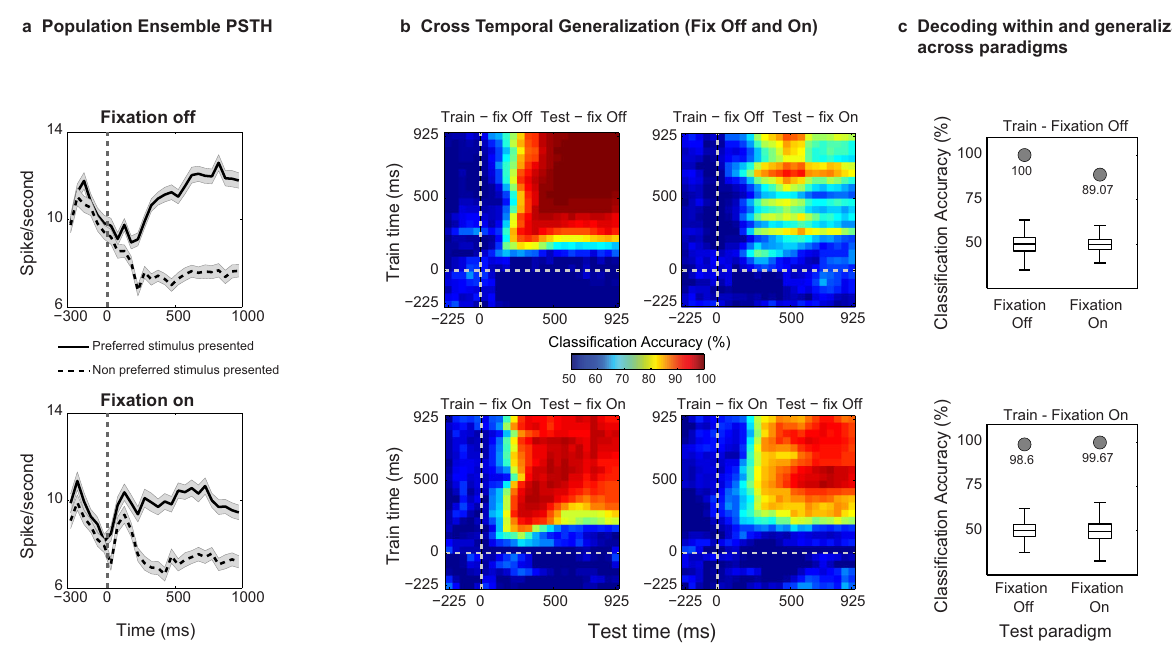
Fig. 7 Decoding of motion content in the presence and during the suppression of OKN eye movements from simultaneously recorded prefrontal ensembles. a , Ensemble population spiking activity (see methods) during fi xation-Off and fi xation-On paradigm for units which were signi fi cantly modulated in either paradigms and preferred the same motion direction (also see methods). Black solid and dashed lines depict the response to the preferred and nonpreferred stimulus respectively. Data are presented as mean and shaded regions depict standard error of the mean. b , Cross-temporal decoding of stimulus contents (binning parameters similar to Fig. 3b). c , Cross-paradigm invariance of the population code was assessed by training a classi fi er on activity during one paradigm and testing on the other, for a single 400 ms bin (starting 400ms poststimulus onset) during visual motion presentation. Signi fi cant (permutation test, one-sided, estimated p -value: p = 0.00199) accuracy (checked by comparing it to accuracy obtained with shuf fl ed labels ( n = 500), summarized with box plots (for box plot description, see statistical information, methods)) suggests that the population code is invariant to the presence of large OKN, and encodes stimulus motion contents. Classi fi cation accuracy for decoding within the paradigm is also presented. The presented results were computed with data from two animals pooled together. We observed similar pattern of results in individual animals, and they are presented in supplementary fi gure 8. Source data are provided as a Source Data fi